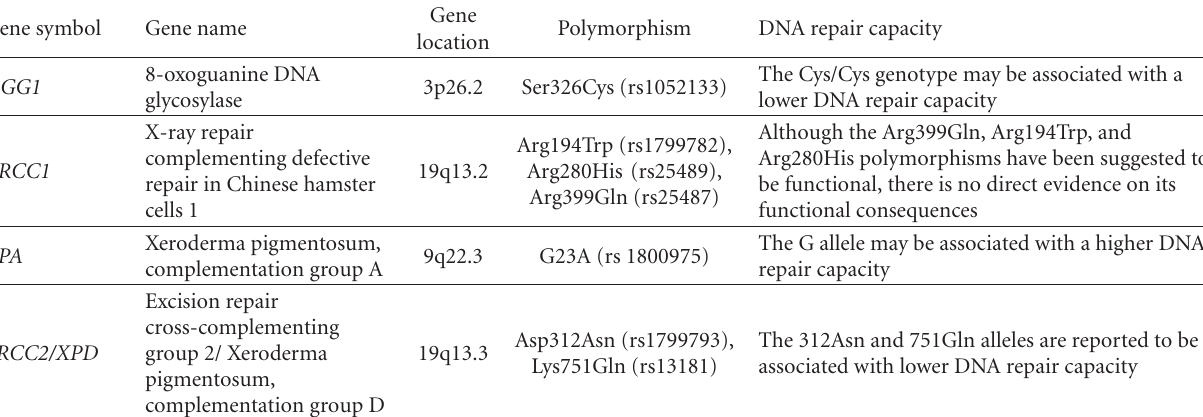
Table 1: The details of the OGG1, XRCC1, XPA , and ERCC/2XPD